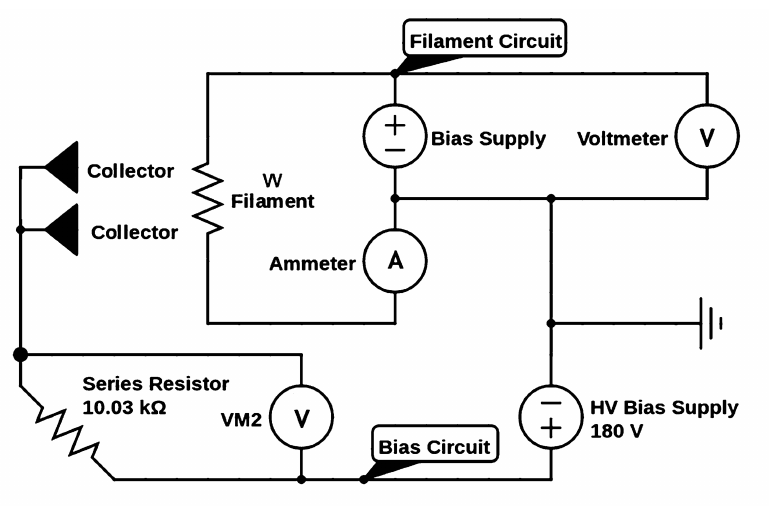
Figure 3. Circuitry of the gauge. Thermionic electrons leave the filament at ground voltage and are pulled by an electric field towards the collectors at a high voltage ( > 200 V+). They then pass through the series resistor and the voltage in voltmeter 2 is proportional to the thermionic emission from the filament.